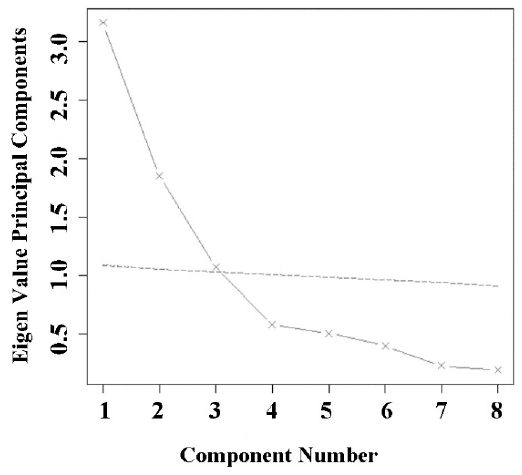
Figure 5. Cattell’s scree plot (a parallel analysis of 100 simulations). Table 6. PCA rotation matrix.